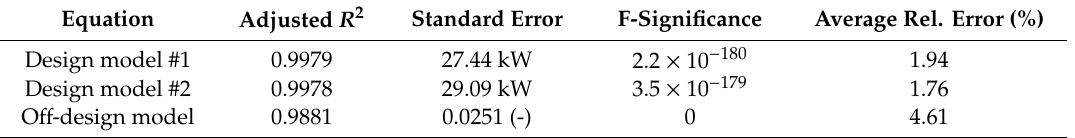
Table 5. Statistical parameters of the proposed regression models.